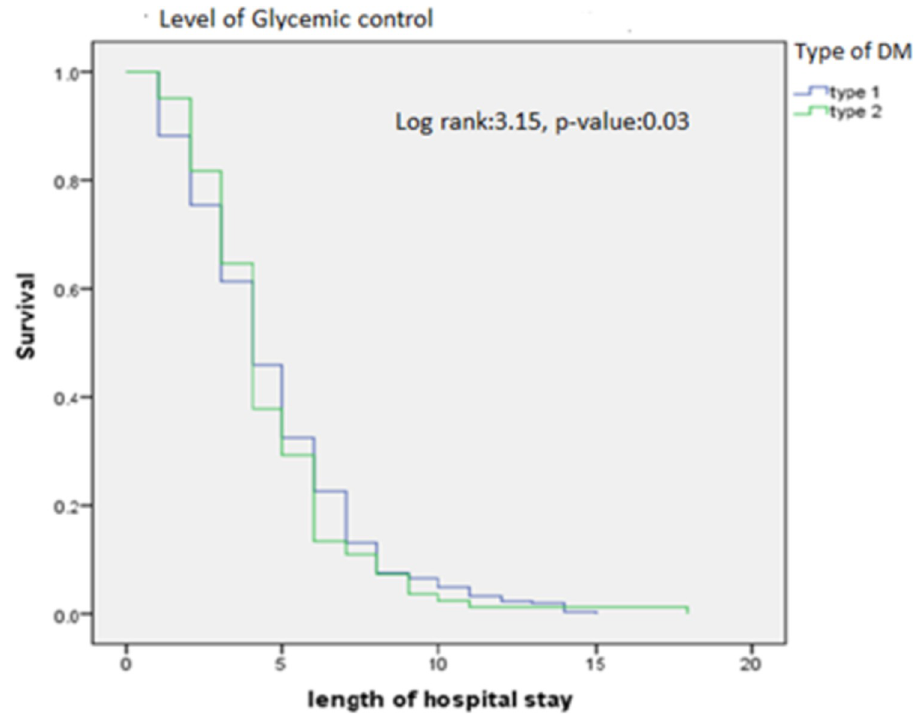
Fig 2. Rate of decline in hyperglycemia among DKA